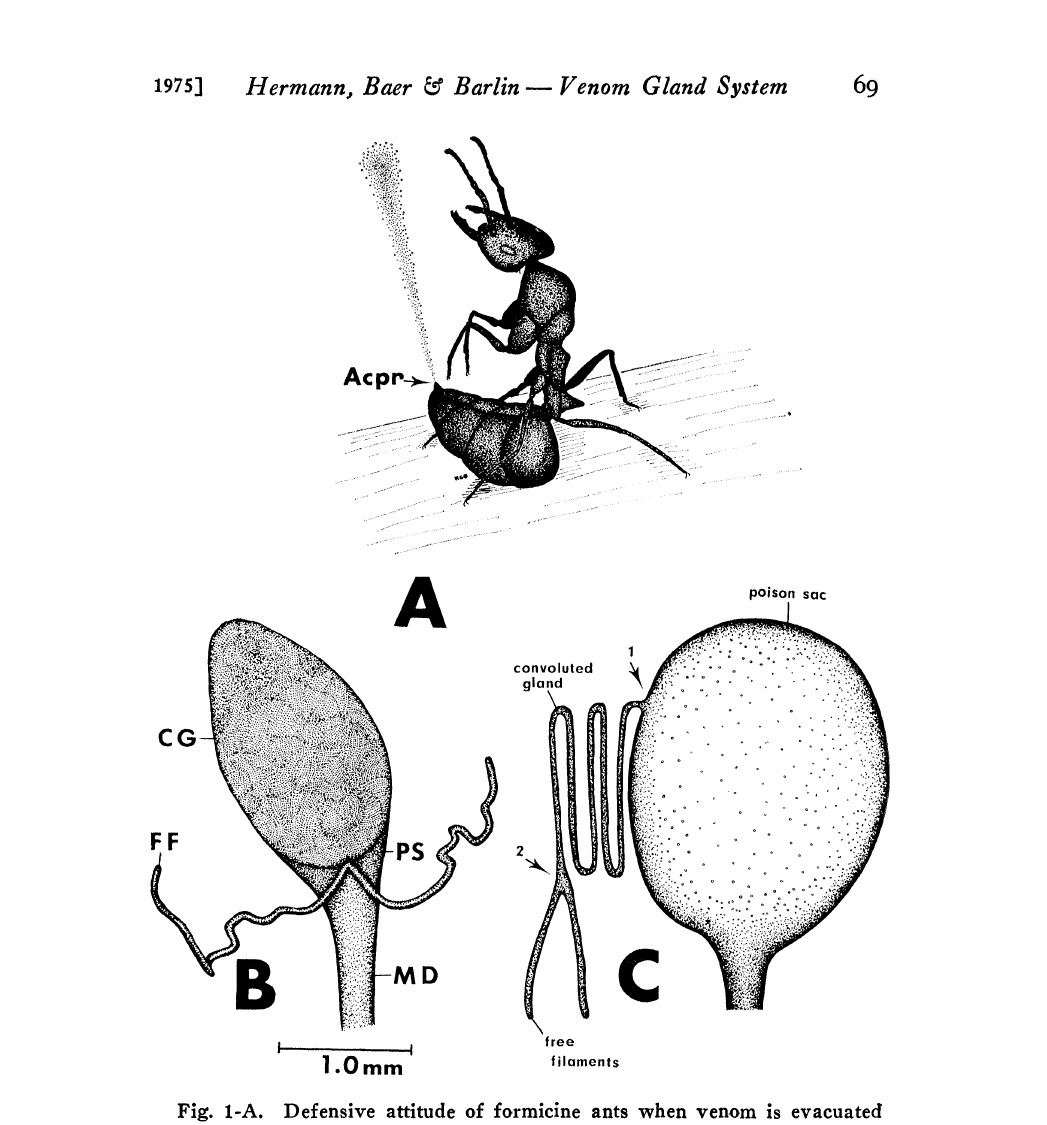
Fig. 1-A. Defensive attitude o.f formicine ants when venom is evacuated through the acidopore. B--Venom sac, showing its component parts in formicine ants. C---Diagrammatie drawing of the venom components and how they attach to one another in formieine ants. Acpr, Acidopore. CG, Convoluted gland. FF, free filamentous glands. PS, Poison sac (venom reservoir. 1, Junction between convoluted gland and venom reservoir. 2, Junction between single and branching ducts of filamentous